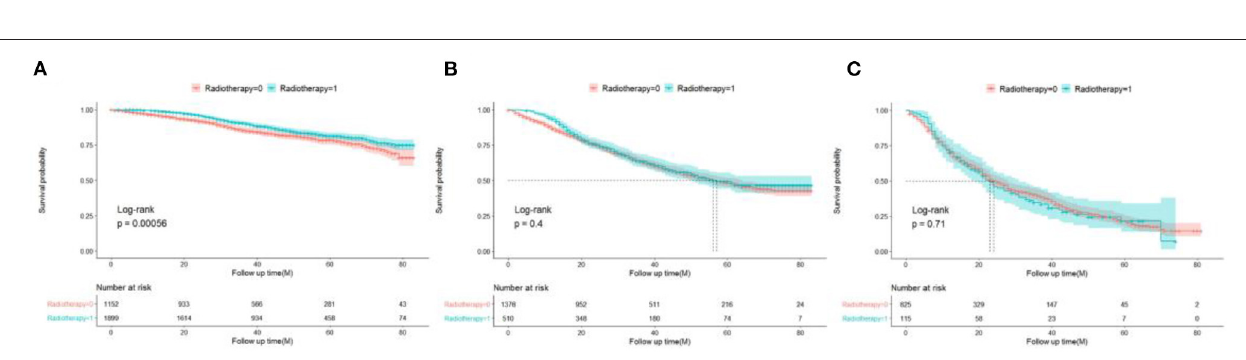
FIGURE 7 | Survival benefits of radiotherapy in low- (A) , medium- (B) , and high-risk (C) groups in elderly patients with